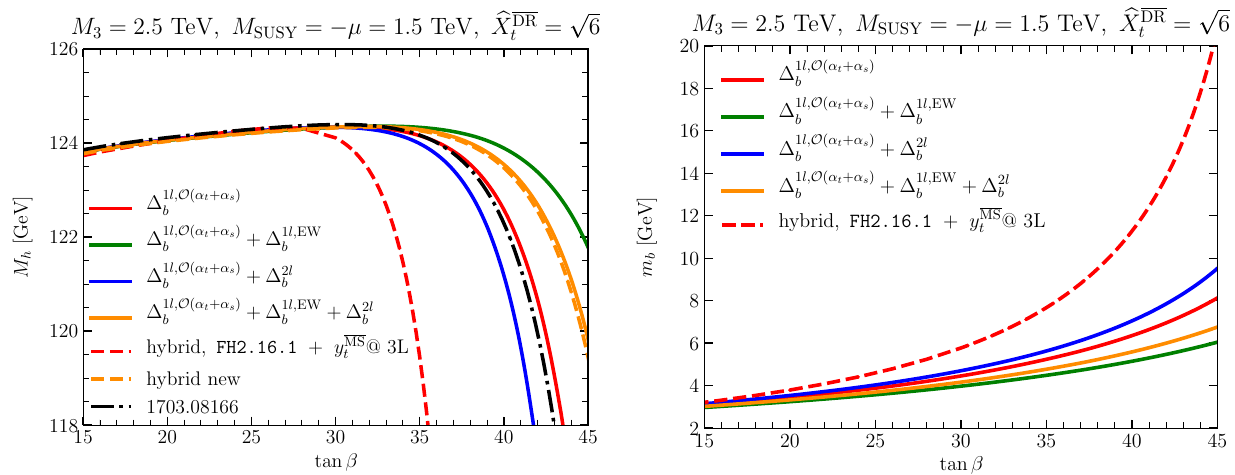
Fig. 1 Predictions for M h (left) and m b (right), which denotes the bottom mass used in the different calculations (see text), as a function of tan β for different accuracy levels in the calculation of (cid:2) b . For this plot we consider the same MSSM scenario as in Fig. 2 of [16]